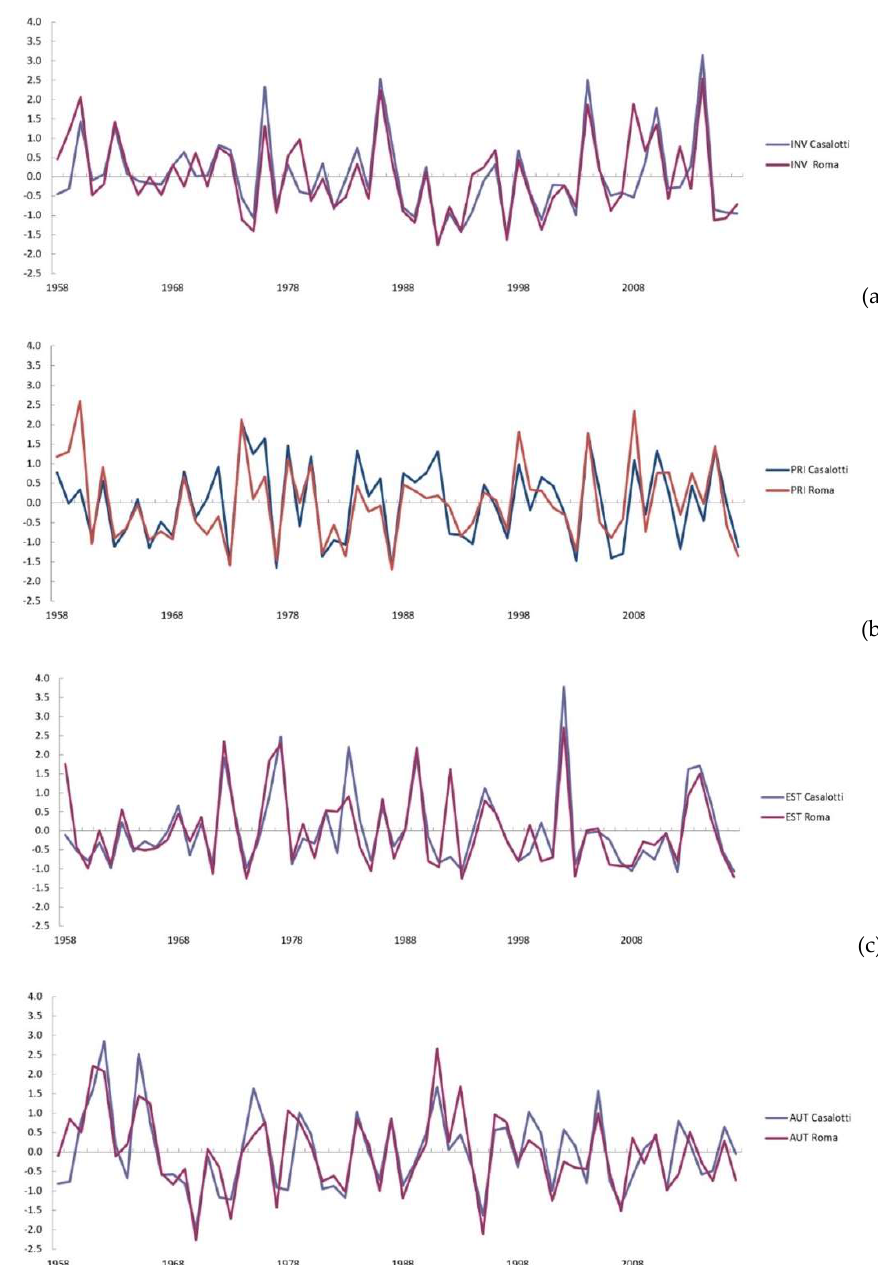
Figure 5. Standardized Precipitation Index (3 months’ time window) in Casalotti (blue) and Collegio Romano (red) by year, 1958–2017, from top to low panels: winter (a), spring (b), summer (c) and autumn (d).